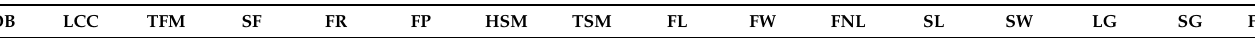
Table 5. Correlation among morpho-agronomic traits of Lagenaria siceraria